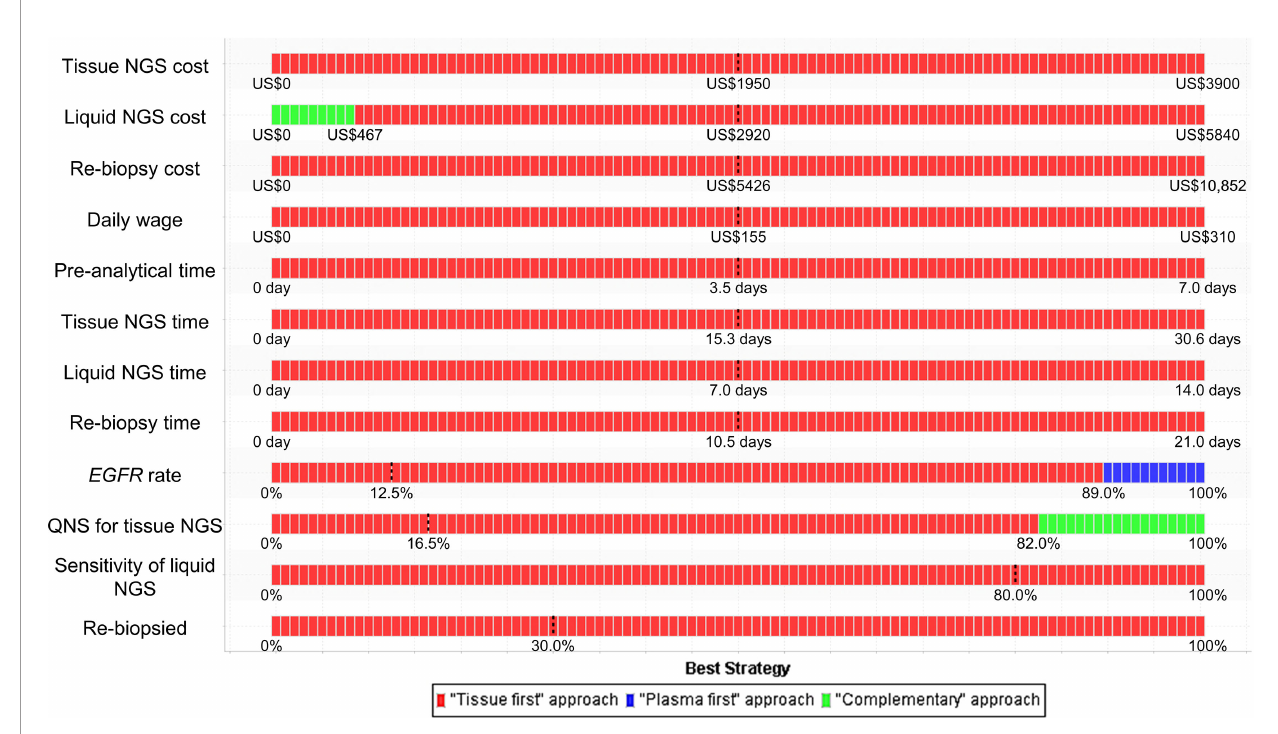
FIGURE 2 | Stacked one-way sensitivity analysis for minimizing monetary loss. We performed a series of one-way sensitivity analyses by varying parameter values in broad ranges ( Table 1 ) and determined the best strategy at each value. The dashed lines represent the baseline values. EGFR , epidermal growth factor receptor; NGS, next-generation sequencing; QNS, quantity not suf fi